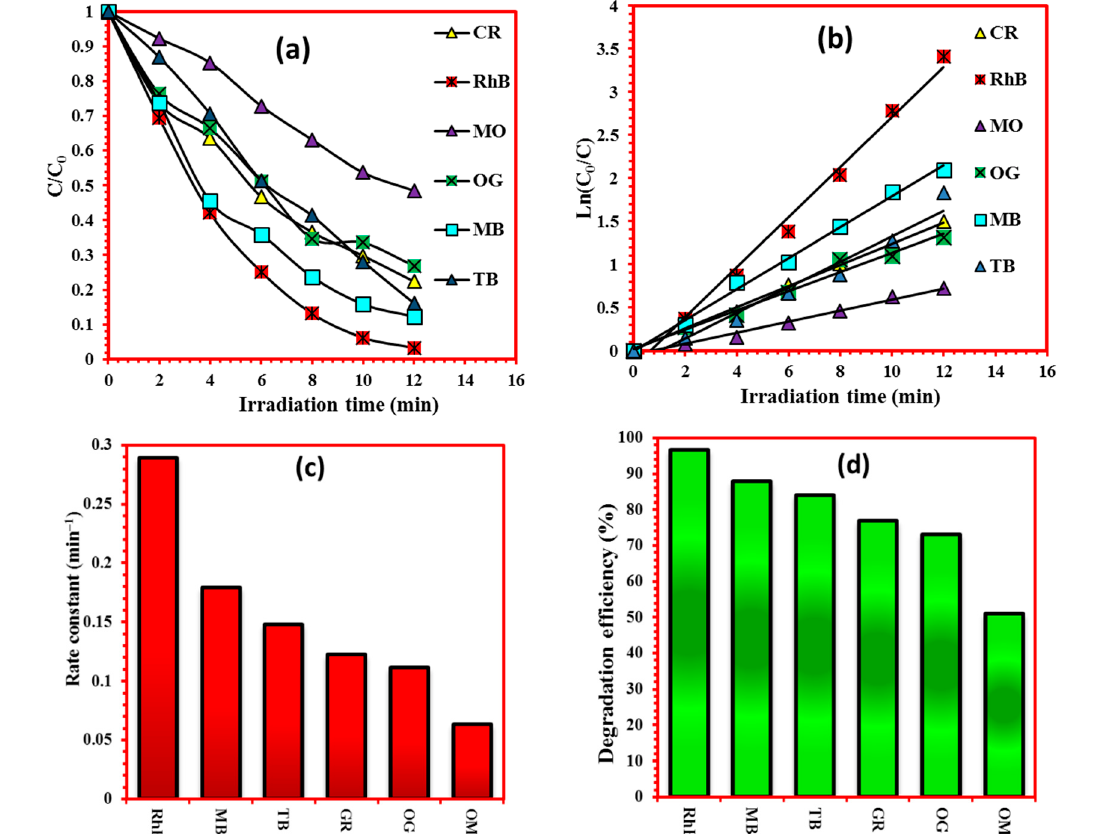
Figure 11. ( a ) Variation in C t /C 0 ratio as a function of time for the different pollutants (RhB, MB, TB, GR, OG, OM); ( b ) pseudo-first-order kinetics of the photodegradation mechanism for all pollutants; ( c ) evolution of the associated apparent rate constant k obs as a function of pollutants; ( d ) efficiency of degradation after irradiation time of 12 min for the degradation of different pollutants.